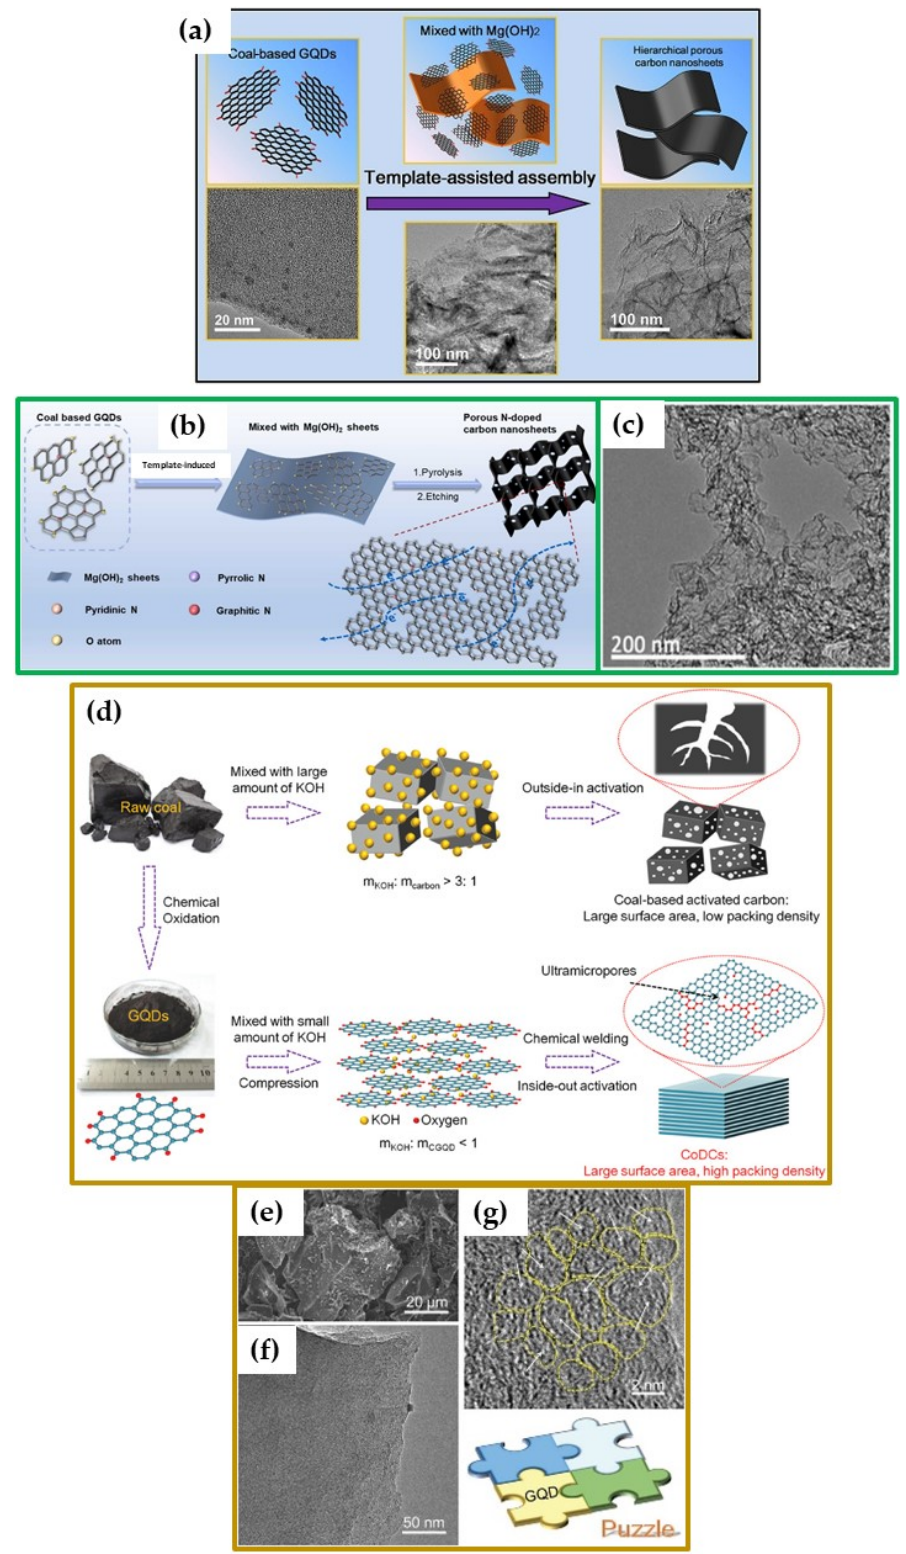
Figure 7. Coal-derived CDs used as precursors for the template-assisted synthesis of ( a ) PCFs (adopted with permission from [91], 2017 Elsevier Ltd.), ( b , c ) N-PCFs (reproduced with permission from [123], 2022 Elsevier B.V.) and ( d – g ) ultra-microporous carbon (adopted with permission [124], 2018 WILEY-VCH Verlag GmbH and Co. KGaA, Weinheim), as well as the TEM images of the resulting products.